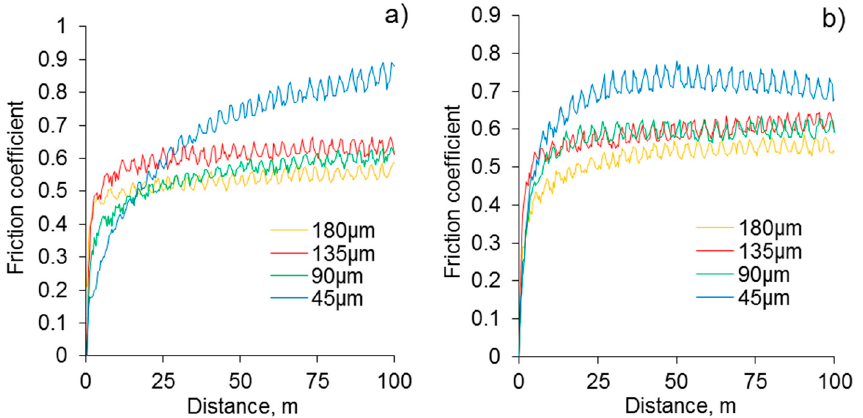
Figure 6. Evolution of friction coefficients during LRWT of PEO coatings with different residual thickness (180, 135, 90, and 45 µm). Normal loads are ( a ) 5 N and ( b ) 10 N. The counterface material is WC-4%Co.